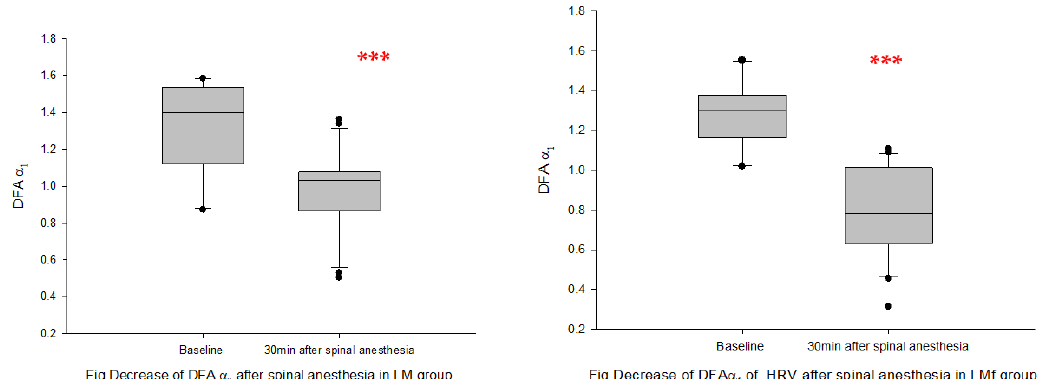
Figure 5. LF/HF ratio at baseline and post-spinal anesthesia. ( A ): Group LM; ( B ): Group LMf; Box plots showing the median, 10th, 25th, 75th, and 90th percentiles as vertical boxes with error bars and plot all data points outside the 10th and 90th percentiles as black circle dots. The significance levels with paired t -tests between baseline and successive measurement periods are as follows: ** p < 0.01; *** p < 0.001.